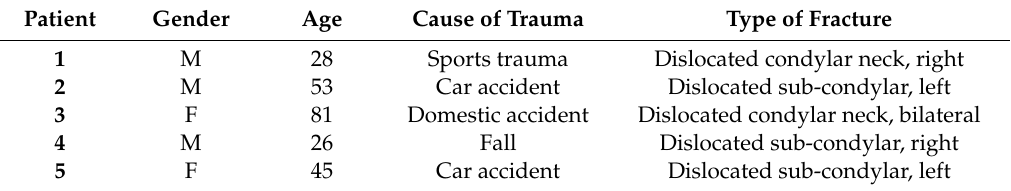
Table 3. Gender, age, and type of trauma of neck condylar fractures or sub-condylar neck fractures. Patient